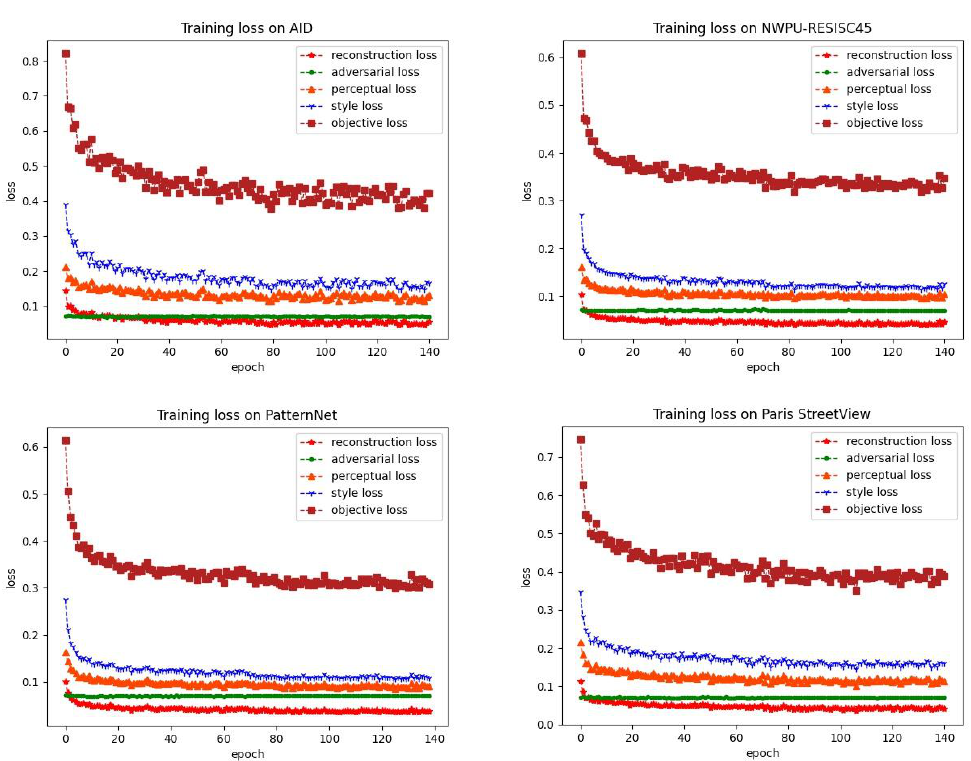
Figure 8. Loss curves of the AID, NWPU-RESISC45, PatternNet, and Paris StreetView datasets.